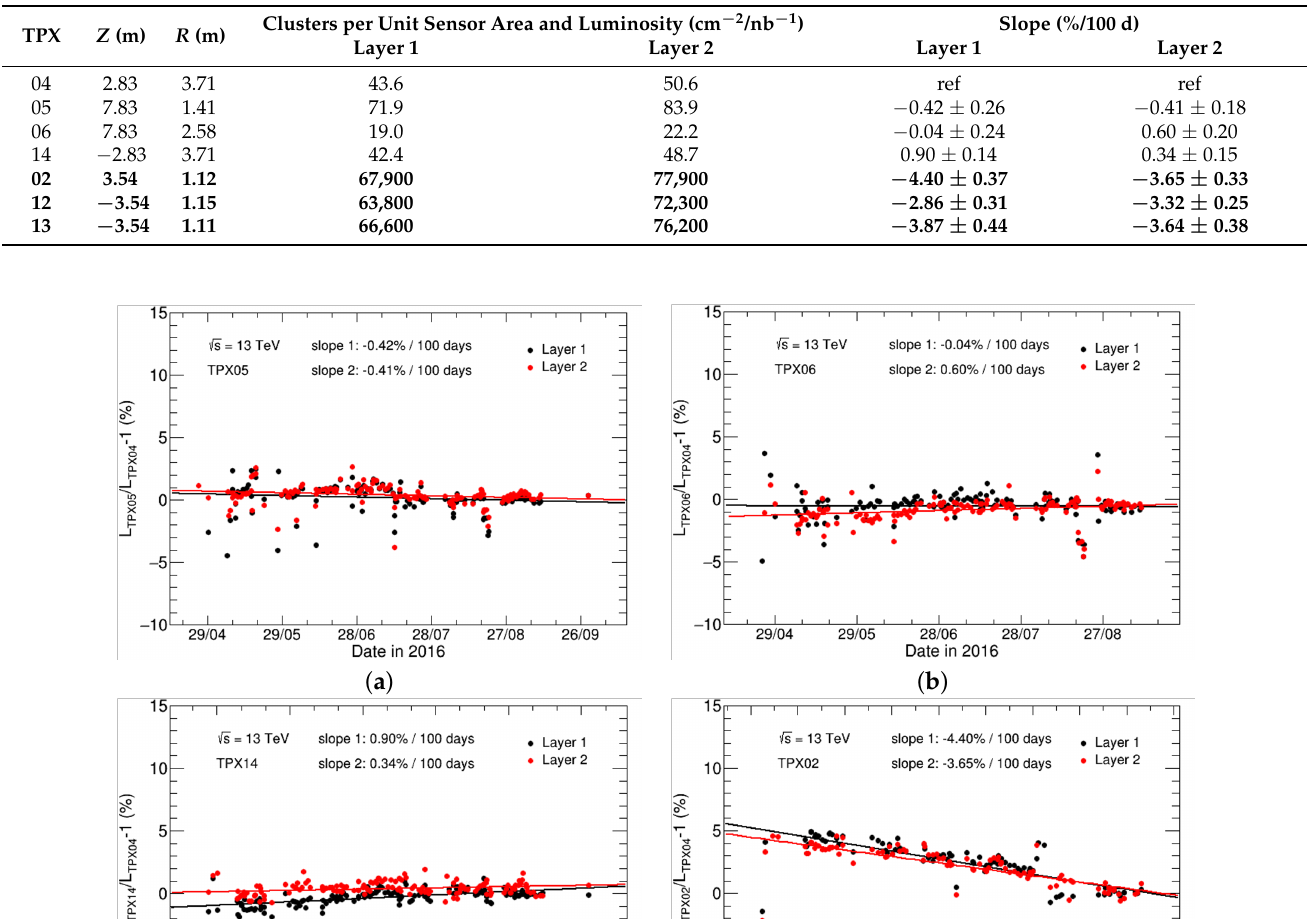
Table 26. Summary of 2016 long-term stability. Z is the distance from the IP along the beam-pipe, and R is the distance from the beam-pipe. High-rate devices are in bold. Taken from Ref. [16].